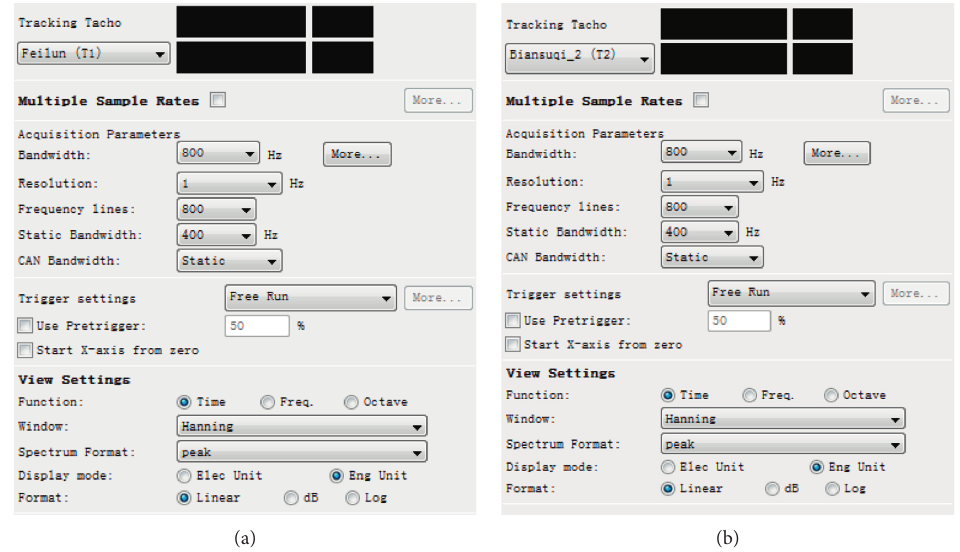
Figure 24: Acquisition setup: (a) acquisition setting of rotating speed signal channel of the primary flywheel; (b) acquisition setting of rotating speed signal channel of the input shaft of the gearbox.